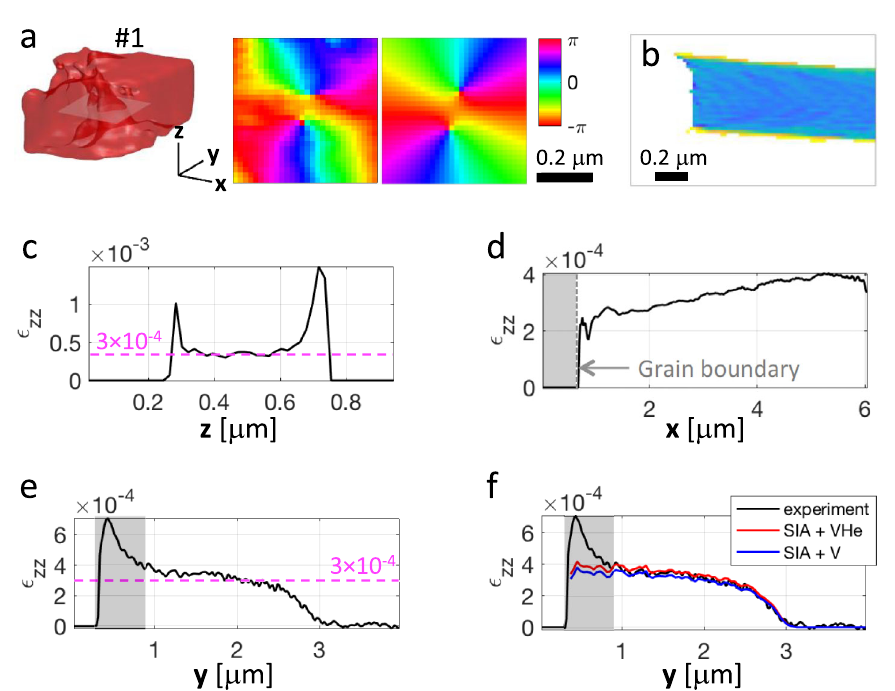
Fig. 5 Extracting displacement fi elds and strain pro fi les. a Left: zoomed-in 3D iso-surface density plots of the dislocation #1 highlighted by a white rectangle in the implanted layer, shown in Fig. 4b, d and f and displayed in the ( x , y , z ) laboratory frame. Middle: 2D cross-section map of the ϕ 220 reconstructed phase. Right: estimated phase variation resulting from simulation (see Supplementary Fig. 8). b Zoomed-in view of the ε zz strain map extracted from the implanted region in the vicinity of the grain boundary (as shown in Fig. 5b). c , d , e One-dimensional cross sections of the average ε zz strain map, across the fi lm thickness, perpendicular to the grain boundary within the implanted region and along the implantation direction, respectively, as indicated in Fig. 4b. In ( e ) the grey area corresponds to a region where ε zz is slightly degraded due to a bit of parasitic aliasing along the y direction. f Calculated strain pro fi le along the implantation direction, assuming the damage microstructure consists of Frenkel pairs with vacancy fi lled by 1 He atom (SIA + VHe) or as Frenkel pairs alone (SIA + V). See Supplementary Fig. 9 for details. All scale bars and angular colour scales in radian are indicated on the